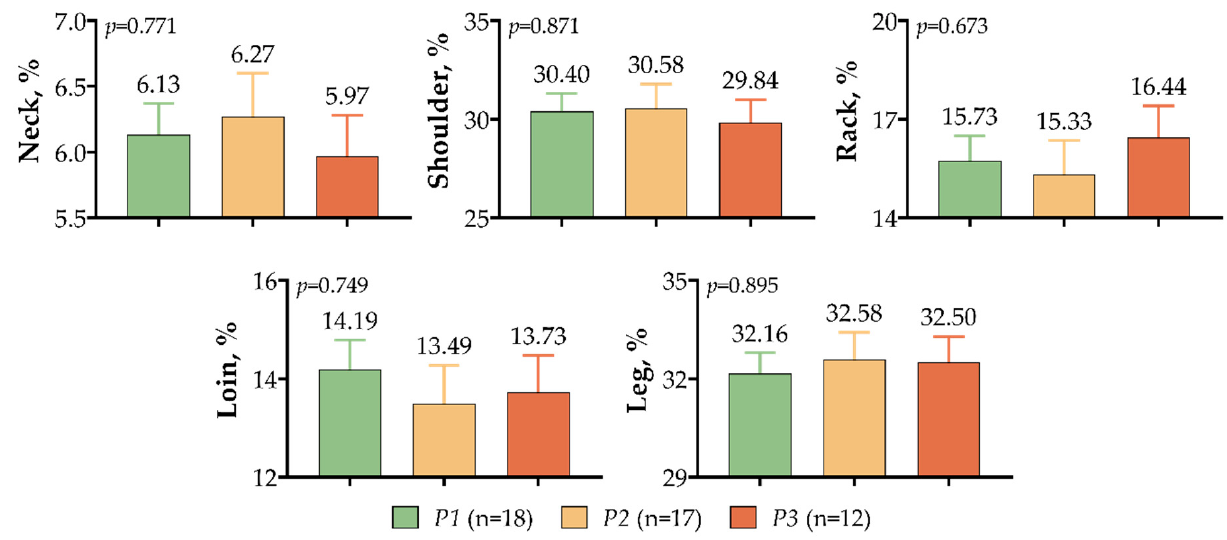
Figure 6. Effect of GHE5 polymorphism on retail carcass percentage of meat-type lambs.